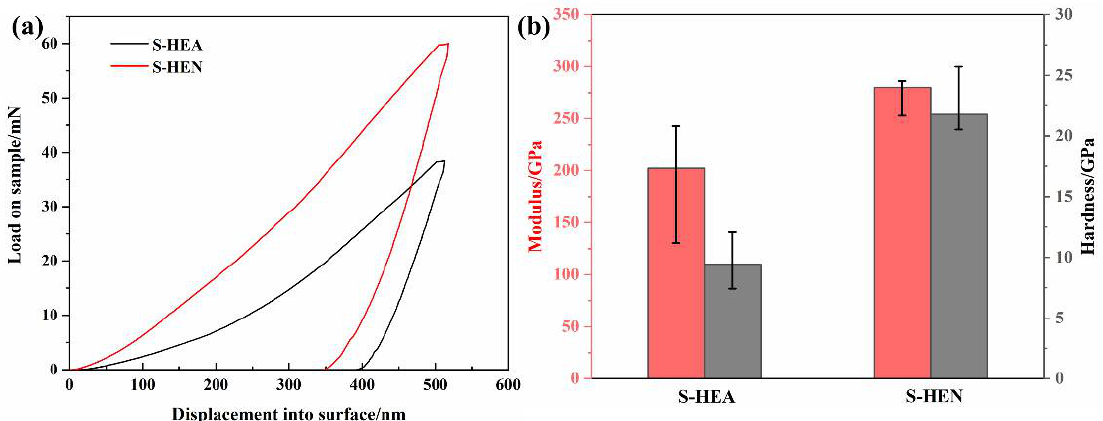
Figure 5. ( a ) Nanoindentation load-displacement curve of S-HEA and S-HEN samples, ( b ) hardness and modulus of the S-HEA and S-HEN samples.